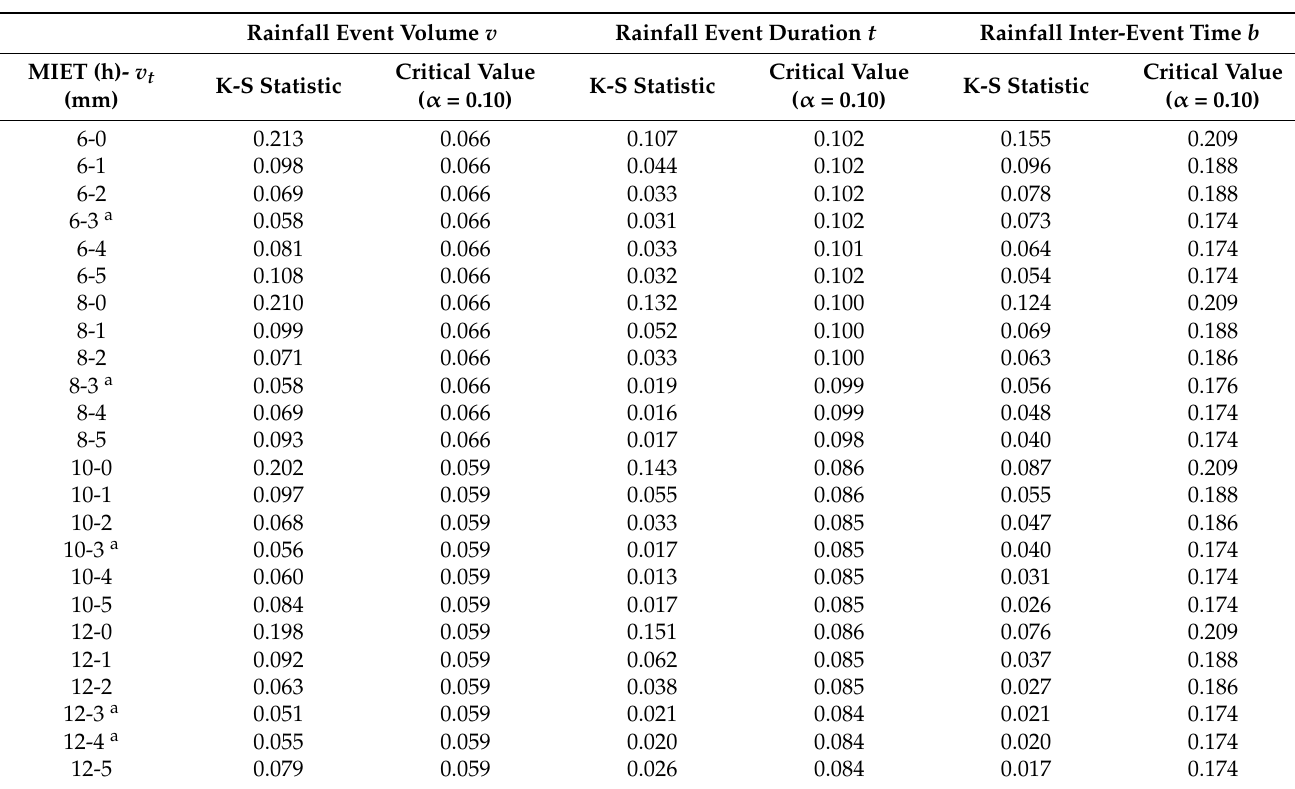
Table 5. Results of K-S statistical tests for Hangzhou.